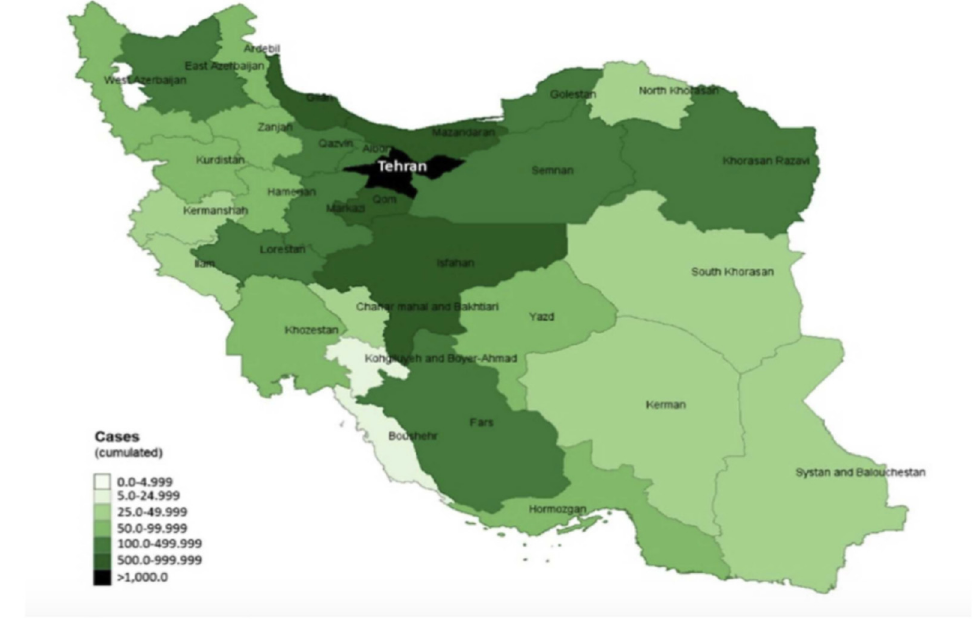
Figure 2. Case distribution by provinces, 9 March 2020. Reproduced from [6], Copyright 2020, Arab-Mazar, Z.; Sah, R.; Rabaan, A.A.; Dhama, K.; Rodriguez-Morales, A.J.